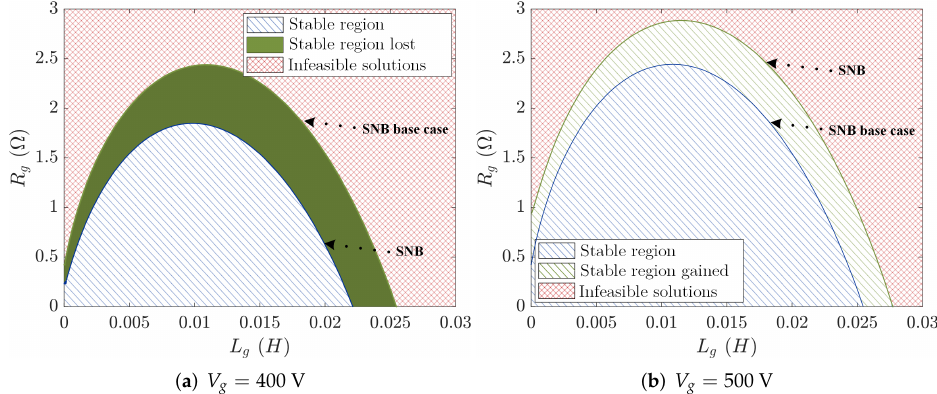
Figure 20. Stability region in L g − R g plane for different Thévenin voltages V g